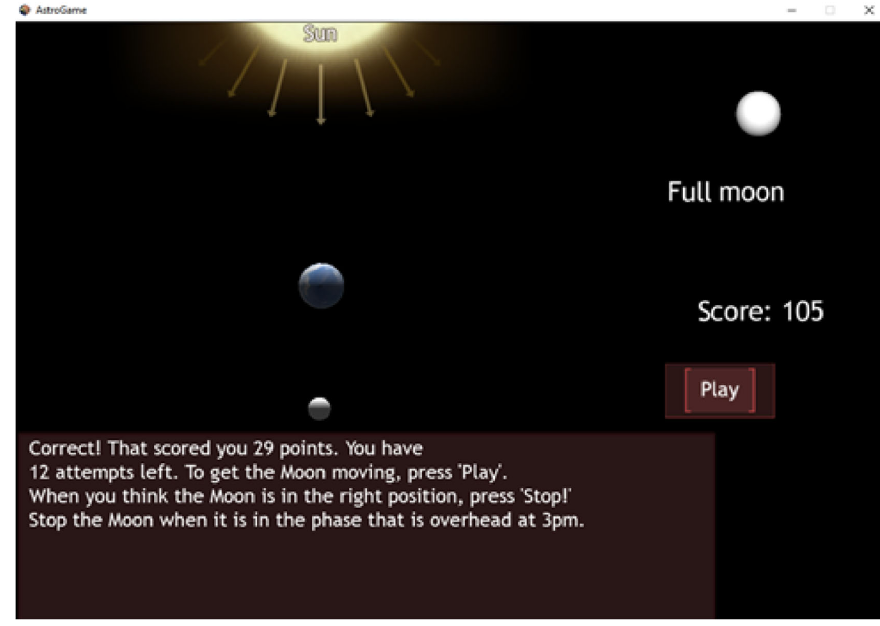
FIG. 3. Screenshot of the Moon Phases minigame taken after a question was answered correctly.